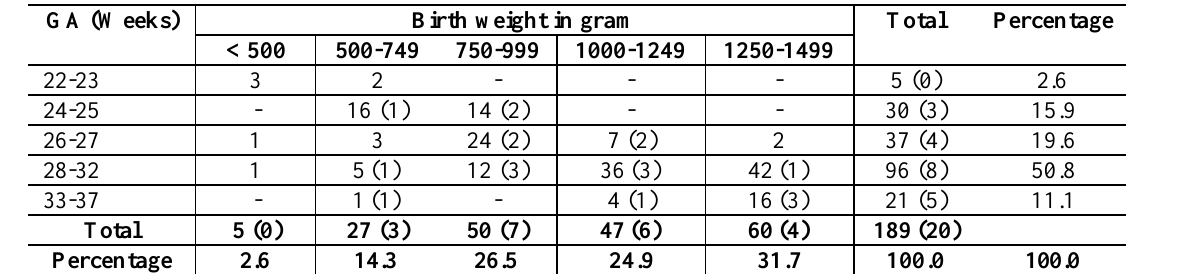
Number in bracket () indicates the number of infants with congenital heart disease. clinical, electrocardigraphic, echocardiographic and angiographic studies. Informed consent from the parents or guardians was obtained according to the hospital’s regulations.